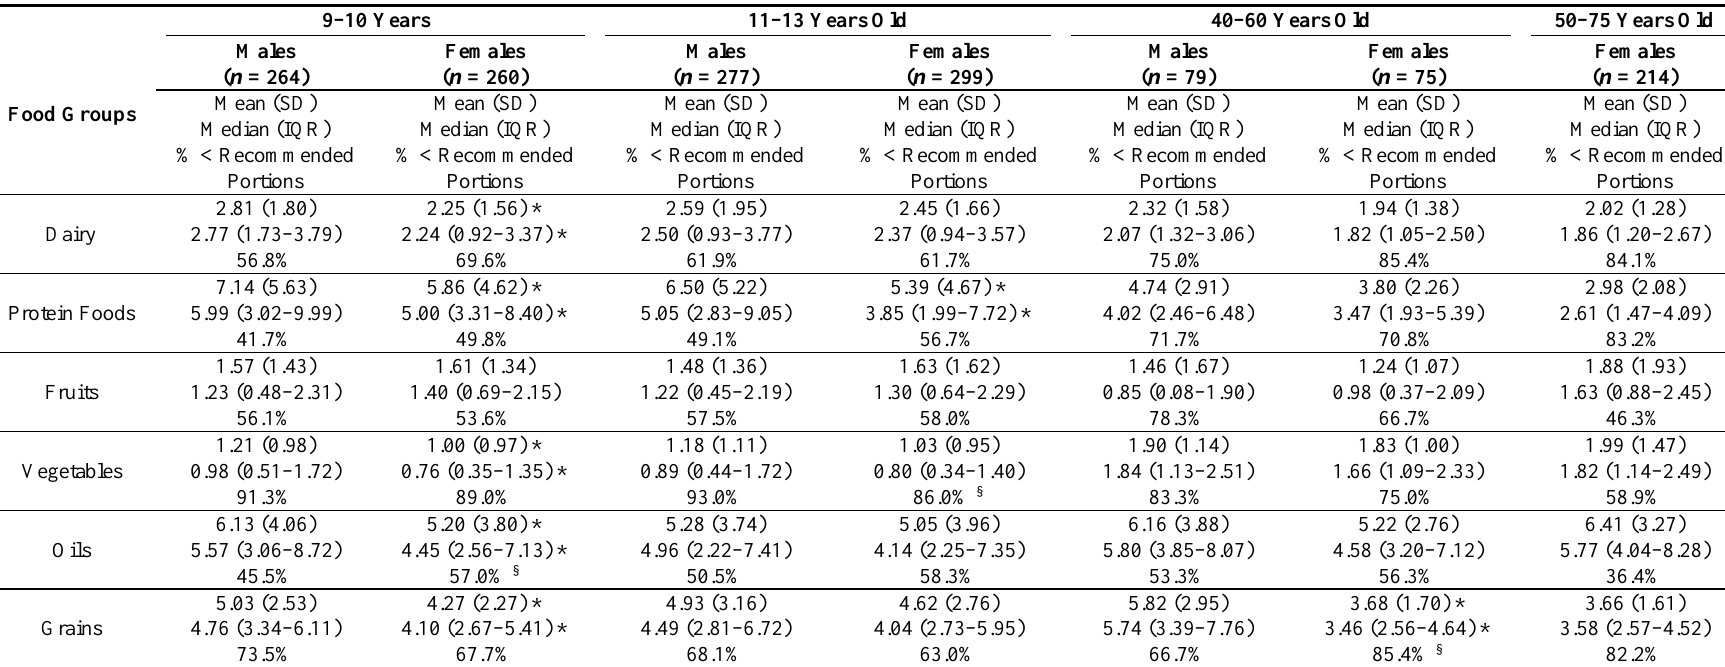
Table 2. Mean (and median) consumption of core food groups and percentages of children, middle-aged adults and postmenopausal women in Greece with consumption below the recommended † portions for each one of these food groups ‡